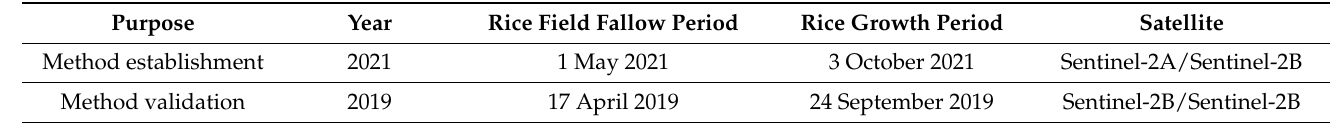
Table 1. Images and their information in the